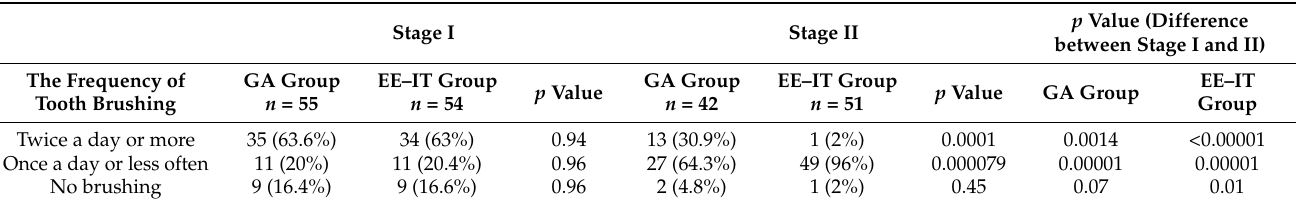
Table 3. The frequency of tooth brushing declared by the GA and EE–IT students in the first and second stage of the